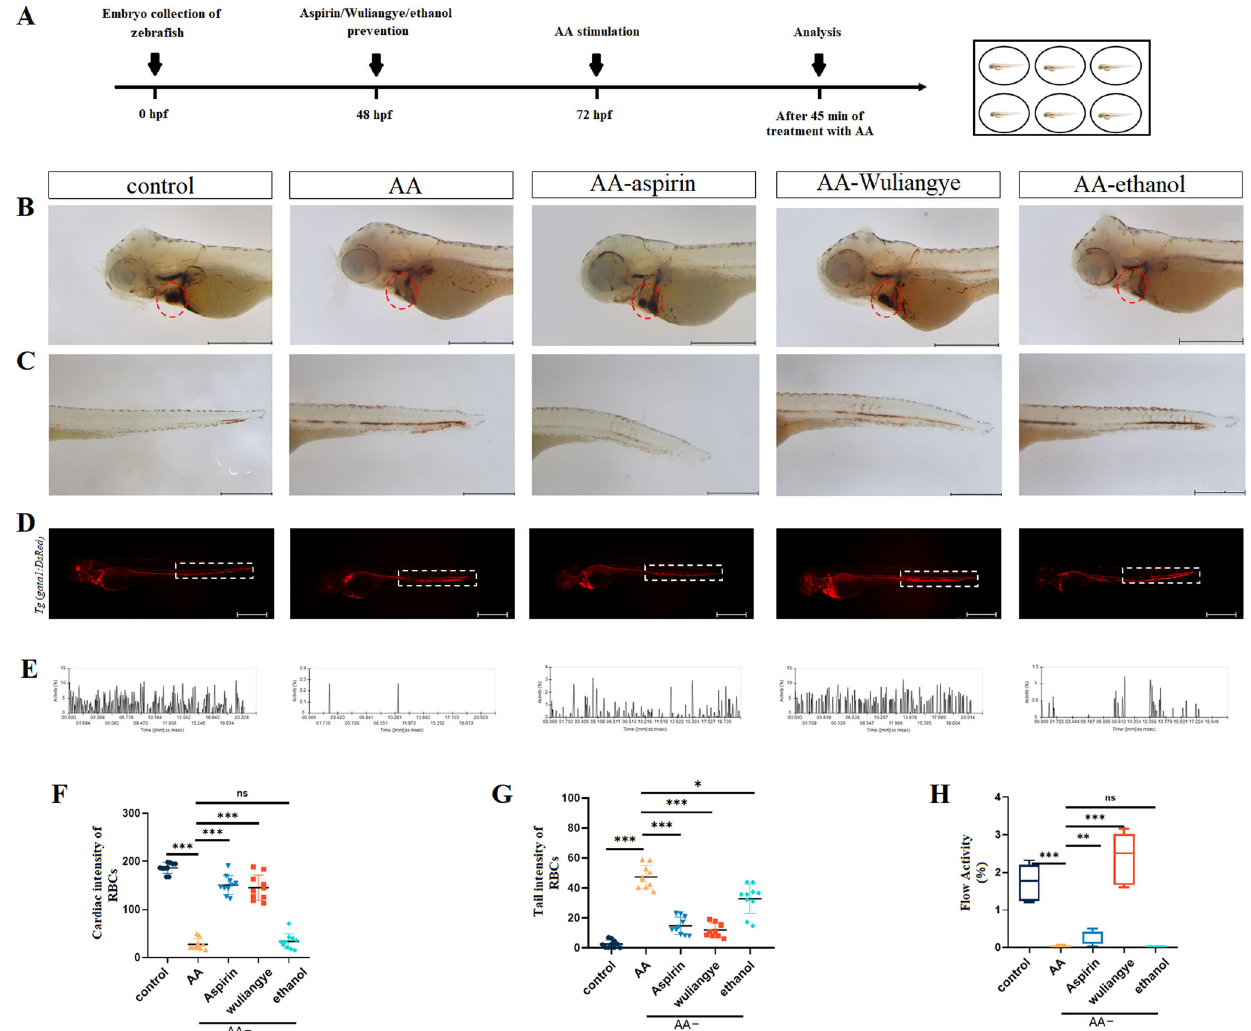
Fig. 1 Wuliangye alleviates thrombosis in the AA-treated zebra fi sh. A Time line of aspirin/Wuliangye (0.3% ethanol, v/v), 0.3% ethanol protection and AA treatment. Representative images ( B ) and quanti fi cation ( F ) of o-dianisidine staining at the heart regions of control, AA, AA- aspirin, AA-Wuliangye, and AA-ethanol groups ( n = 10). The heart regions are circled by red dotted line. C , G Representative images ( C ) and quanti fi cation ( G ) of o-dianisidine staining at the tail regions control, AA, aspirin, Wuliangye and ethanol treated ( n = 10). Scale bar = 500 μ m. All data are presented with mean ± standard deviation (solid bar). D Blood cell aggregation of Tg (gata1:DsRed) zebra fi sh in control group, AA group, aspirin group, Wuliangye group and ethanol group. E Blood fl ow velocity frequency diagram of zebra fi sh in control, AA, aspirin, Wuliangye and ethanol treated. H Boxplots of blood fl ow velocity statistics of control, AA, AA-aspirin, AA-Wuliangye and AA-ethanol groups, the boxes are outlined from the fi rst quartile to the third quartile, the center line that goes through the box is the median, the whiskers (small lines) go from each quartile towards the minimum or maximum value. Compared with the control group; compared with the model group, ns for not signi fi cant, * P < 0.05, ** P < 0.01, *** P < 0.001 ( t